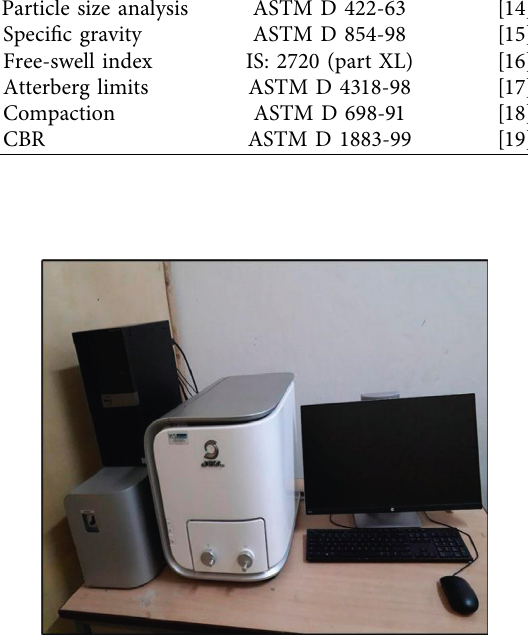
Figure 2: JCM-6000 PLUS Bench Top SEM JEOL SEM machine